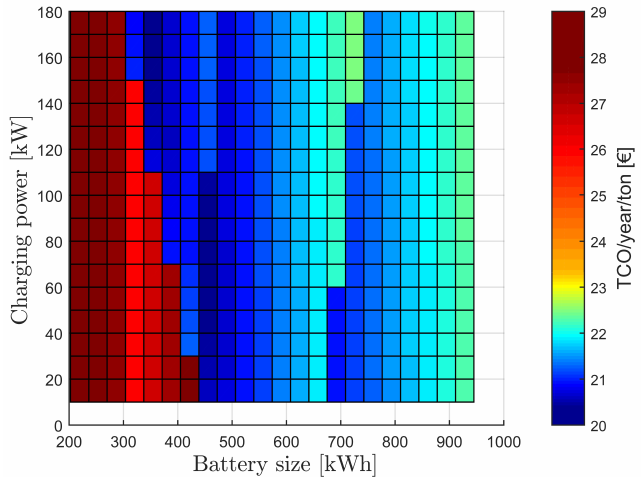
Figure 17. TCO versus battery size and charging